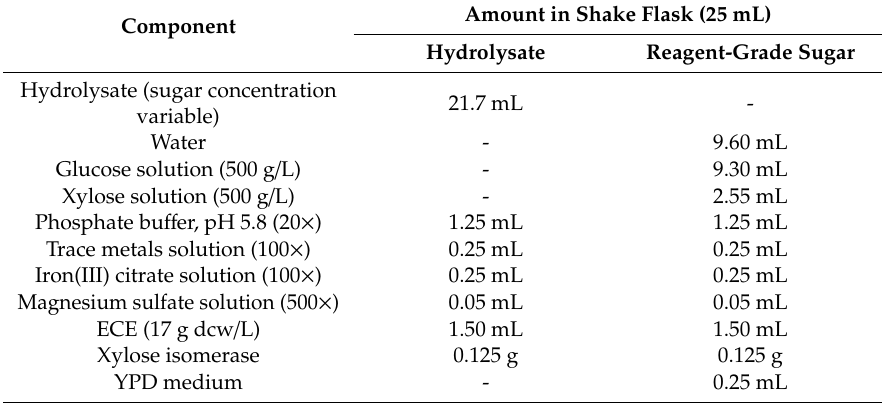
Table 2. Component additions for a 25-mL shake flask fermentation. The water, glucose, and xylose solution volumes required for a reagent-grade sugar fermentation depend on the sugar concentrations in the hydrolysate. For illustration, the target concentrations for the reagent fermentation broth were 186 g / L glucose and 51 g / L